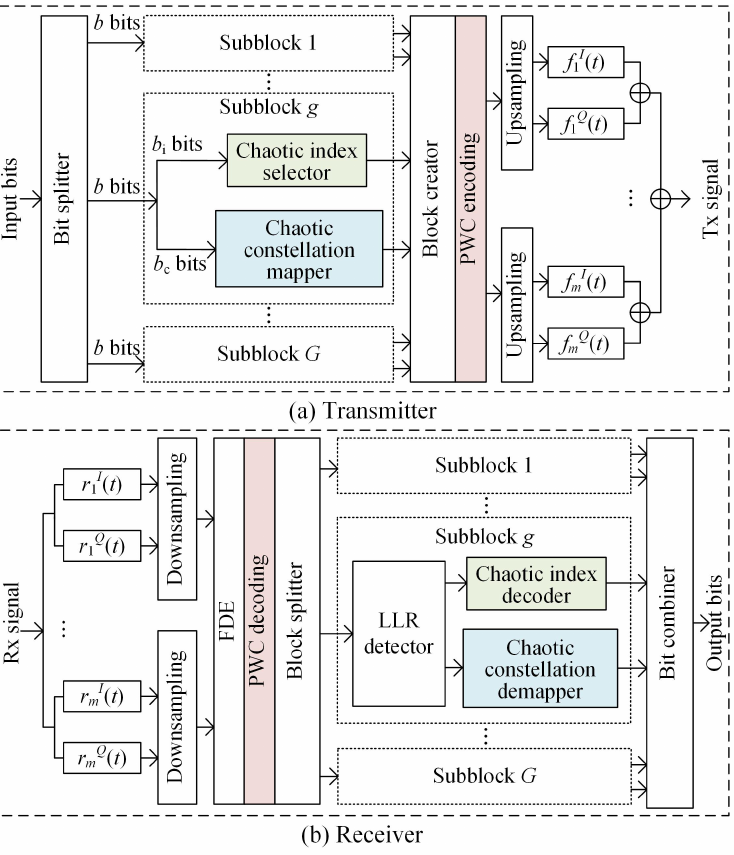
Figure 1. Block diagrams of the proposed PWC-based m CAP-DM with 2D chaotic encryption: ( a ) transmitter and ( b )